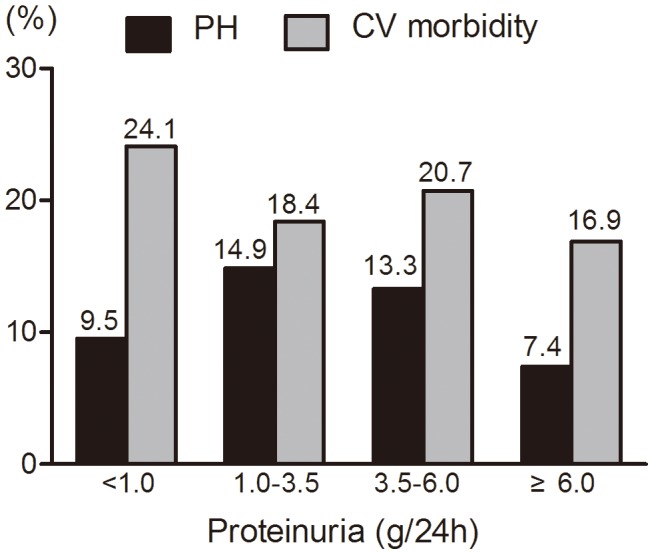
Prevalence of PH and CV morbidity stratified by proteinuria (not including CKD Stage 5D).PH was more prevalent in proteinuria ranging from 1.0 g/24 h to 6.0 g/24 h, but was less prevalent in patients with proteinuria less than 1.0 g/24 h or more than 6.0 g/24 h.